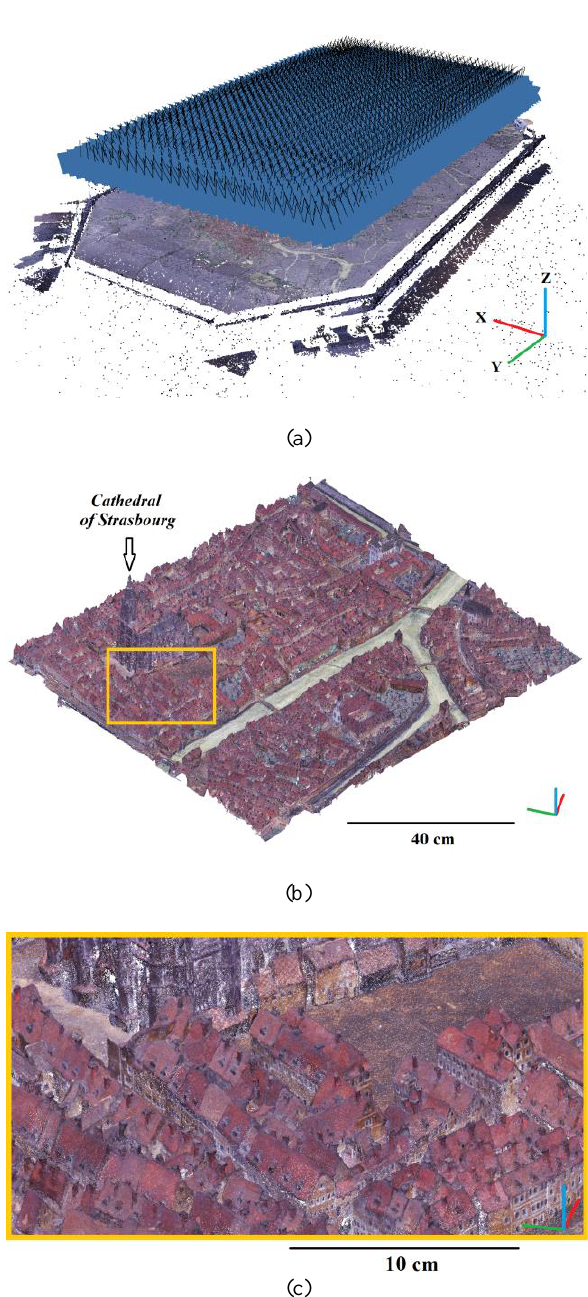
Figure 3. Data post-processing: (a) positioning of the photographs; (b) dense point cloud generated for a part of the scale model (~111M points, 1 m per 0.9 m); (c) zoom on dense point